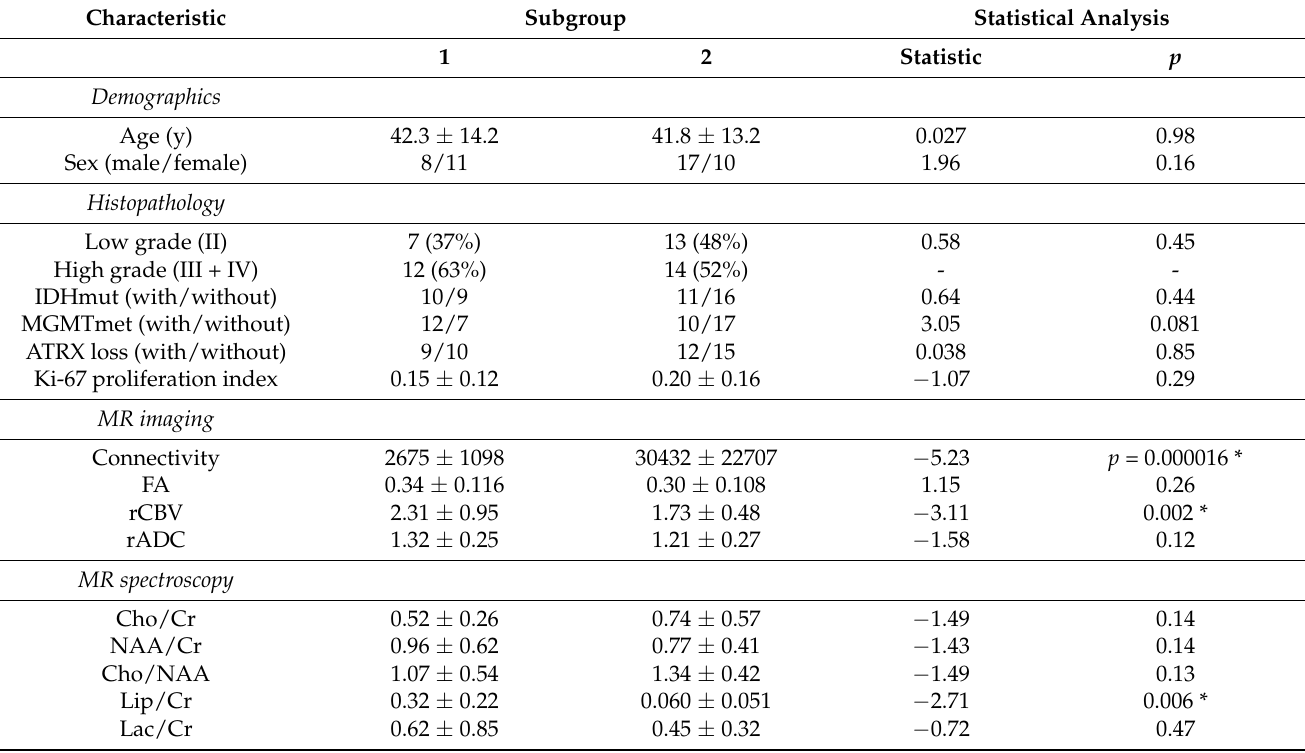
Table 2. Demographic, histopathological, and MR imaging and spectroscopy results in the two subgroups.